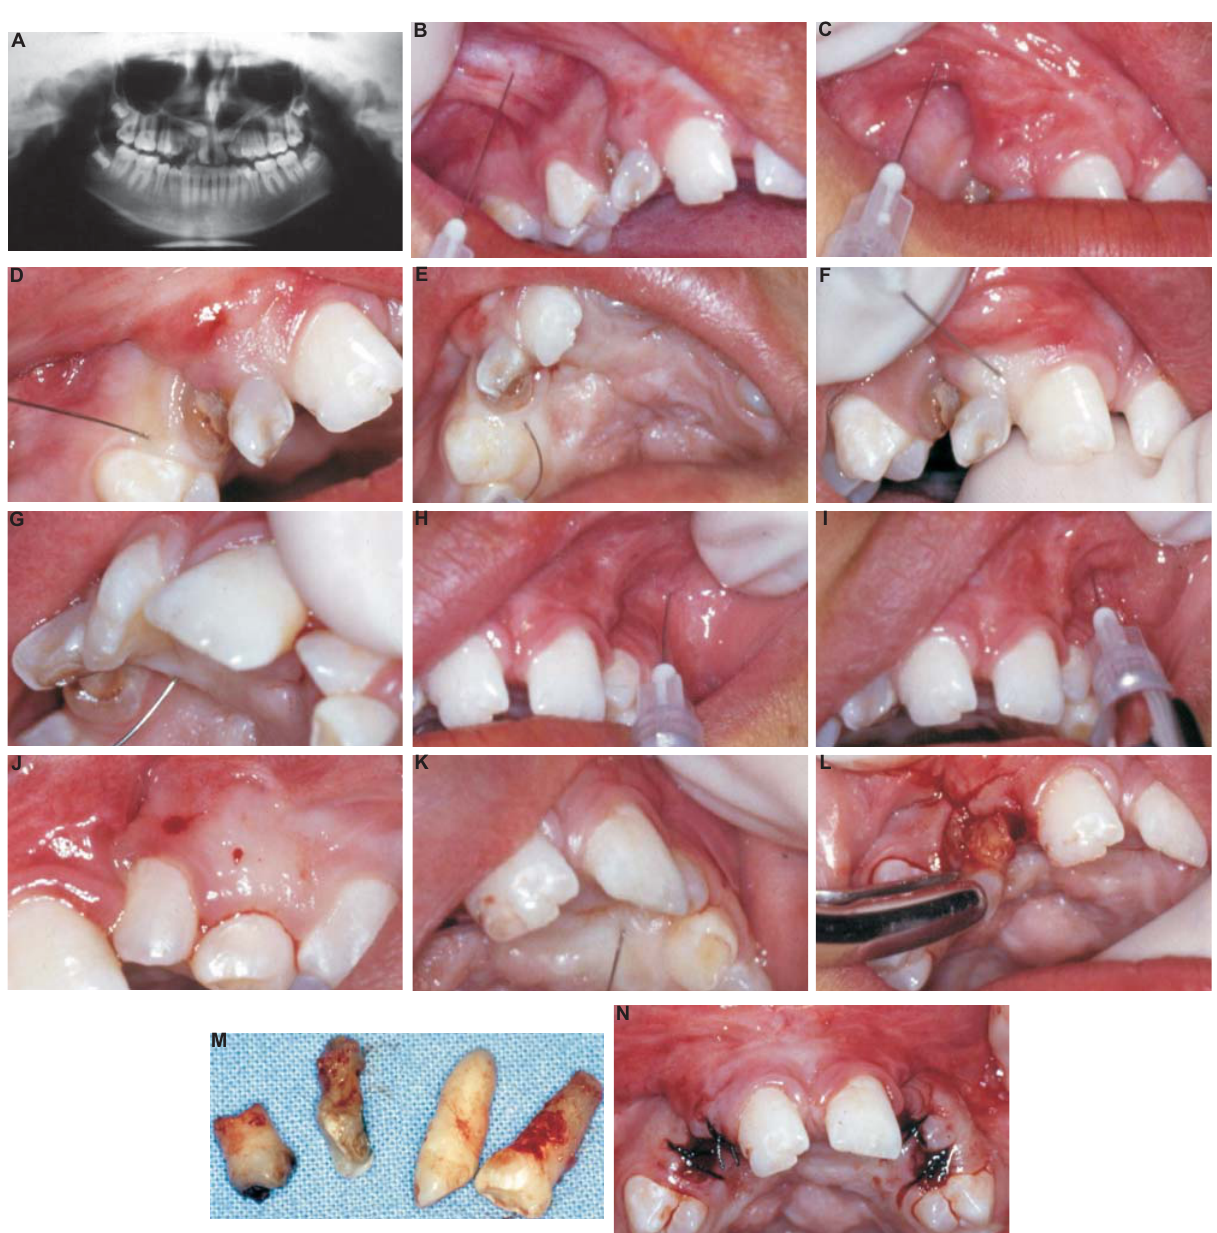
Figure 2- Patient with a complete bilateral cleft lip and palate:A: Panoramic radiograph showing residual teeth in the right (cid:30)(cid:11)(cid:17)(cid:31)(cid:2)(cid:5)(cid:8)(cid:13)(cid:14)(cid:5)(cid:9)(cid:18)(cid:15)(cid:17)(cid:12)(cid:13)(cid:18)(cid:10)(cid:17)(cid:12)(cid:8)(cid:12)"(cid:5)(cid:2)(cid:17)(cid:17)(cid:2)(cid:4)(cid:5)(cid:7)(cid:13)(cid:5)(cid:2)(cid:4)(cid:17)(cid:5)(cid:11)(cid:17)(cid:31)(cid:2)(cid:5)(cid:30)(cid:11)(cid:17)(cid:31)(cid:2)$(cid:5)(cid:6)(cid:7)(cid:2)(cid:4)(cid:5)(cid:15)(cid:3)(cid:3)(cid:12)(cid:5)(cid:16)(cid:3)(cid:13)(cid:17)(cid:5)(cid:9)(cid:18)(cid:15)(cid:15)(cid:3)(cid:12)(cid:2)(cid:19)(cid:5)(cid:20)(cid:21)(cid:5)(cid:22)(cid:13)(cid:2)(cid:12)(cid:8)(cid:3)(cid:12)(cid:8)(cid:11)(cid:5)(cid:23)(cid:7)(cid:17)(cid:6)(cid:5)(cid:8)(cid:13)(cid:14)(cid:5)(cid:26)(cid:12)(cid:9)(cid:2)(cid:5)(cid:7)(cid:13)(cid:26)(cid:11)(cid:2)(cid:12)(cid:8)(cid:2)(cid:7)(cid:3)(cid:13)(cid:5)(cid:7)(cid:13)(cid:5)(cid:2)(cid:4)(cid:17)(cid:5)(cid:15)(cid:12)(cid:17)(cid:10)(cid:3)(cid:11)(cid:8)(cid:12)(cid:5) (cid:12)(cid:17)(cid:27)(cid:7)(cid:3)(cid:13)(cid:19)(cid:5)(cid:24)(cid:21)(cid:5)(cid:29)(cid:17)(cid:30)(cid:3)(cid:13)(cid:14)(cid:5)(cid:7)(cid:13)(cid:26)(cid:11)(cid:2)(cid:12)(cid:8)(cid:2)(cid:7)(cid:3)(cid:13)(cid:5)(cid:7)(cid:13)(cid:5)(cid:2)(cid:4)(cid:17)(cid:5)(cid:30)(cid:11)(cid:17)(cid:31)(cid:2)(cid:5)(cid:8)(cid:12)(cid:17)(cid:8)(cid:19)(cid:5)(cid:28)(cid:21)(cid:5)(cid:22)(cid:13)(cid:26)(cid:11)(cid:2)(cid:12)(cid:8)(cid:2)(cid:7)(cid:3)(cid:13)(cid:5)(cid:7)(cid:13)(cid:5)(cid:2)(cid:4)(cid:17)(cid:5)(cid:16)(cid:18)(cid:30)(cid:30)(cid:8)(cid:11)(cid:5)(cid:8)(cid:9)(cid:15)(cid:17)(cid:30)(cid:2)(cid:5)(cid:3)(cid:31)(cid:5)(cid:2)(cid:4)(cid:17)(cid:5)(cid:10)(cid:8)(cid:12)(cid:27)(cid:7)(cid:13)(cid:8)(cid:11)(cid:5)(cid:27)(cid:17)(cid:13)(cid:27)(cid:7)(cid:23)(cid:8)(cid:5)(cid:8)(cid:14)%(cid:8)(cid:30)(cid:17)(cid:13)(cid:2)(cid:5)(cid:2)(cid:3)(cid:5)(cid:2)(cid:4)(cid:17)(cid:5) (cid:30)(cid:11)(cid:17)(cid:31)(cid:2)(cid:5)&(cid:15)(cid:3)(cid:9)(cid:2)(cid:17)(cid:12)(cid:7)(cid:3)(cid:12)(cid:5)(cid:10)(cid:8)’(cid:7)(cid:11)(cid:11)(cid:8)(cid:12)"(cid:5)(cid:9)(cid:17)(cid:27)(cid:10)(cid:17)(cid:13)(cid:2)(cid:5)*(cid:5)(cid:12)(cid:7)(cid:27)(cid:4)(cid:2)(cid:5)(cid:9)(cid:7)(cid:14)(cid:17)+(cid:19)(cid:5)!(cid:21)(cid:5)(cid:22)(cid:13)(cid:26)(cid:11)(cid:2)(cid:12)(cid:8)(cid:2)(cid:7)(cid:3)(cid:13)(cid:5)(cid:7)(cid:13)(cid:5)(cid:15)(cid:8)(cid:11)(cid:8)(cid:2)(cid:8)(cid:11)(cid:5)(cid:8)(cid:9)(cid:15)(cid:17)(cid:30)(cid:2)(cid:5)(cid:3)(cid:31)(cid:5)(cid:2)(cid:4)(cid:17)(cid:5)(cid:10)(cid:8)(cid:12)(cid:27)(cid:7)(cid:13)(cid:8)(cid:11)(cid:5)(cid:27)(cid:17)(cid:13)(cid:27)(cid:7)(cid:23)(cid:8)(cid:5)(cid:8)(cid:14)%(cid:8)(cid:30)(cid:17)(cid:13)(cid:2)(cid:5)(cid:2)(cid:3)(cid:5)(cid:2)(cid:4)(cid:17)(cid:5)(cid:30)(cid:11)(cid:17)(cid:31)(cid:2)(cid:5) &(cid:2)(cid:4)(cid:17)(cid:5)(cid:15)(cid:3)(cid:9)(cid:2)(cid:17)(cid:12)(cid:7)(cid:3)(cid:12)(cid:5)(cid:10)(cid:8)’(cid:7)(cid:11)(cid:11)(cid:8)(cid:12)"(cid:5)(cid:9)(cid:17)(cid:27)(cid:10)(cid:17)(cid:13)(cid:2)(cid:5)*(cid:5)(cid:12)(cid:7)(cid:27)(cid:4)(cid:2)(cid:5)(cid:9)(cid:7)(cid:14)(cid:17)+(cid:19)(cid:5)(cid:25)(cid:21)(cid:5)(cid:22)(cid:13)(cid:26)(cid:11)(cid:2)(cid:12)(cid:8)(cid:2)(cid:7)(cid:3)(cid:13)(cid:5)(cid:7)(cid:13)(cid:5)(cid:2)(cid:4)(cid:17)(cid:5)(cid:16)(cid:18)(cid:30)(cid:30)(cid:8)(cid:11)(cid:5)(cid:8)(cid:9)(cid:15)(cid:17)(cid:30)(cid:2)(cid:5)(cid:3)(cid:31)(cid:5)(cid:2)(cid:4)(cid:17)(cid:5)(cid:10)(cid:8)(cid:12)(cid:27)(cid:7)(cid:13)(cid:8)(cid:11)(cid:5)(cid:27)(cid:17)(cid:13)(cid:27)(cid:7)(cid:23)(cid:8)(cid:5)(cid:8)(cid:14)%(cid:8)(cid:30)(cid:17)(cid:13)(cid:2)(cid:5)(cid:2)(cid:3)(cid:5)(cid:2)(cid:4)(cid:17)(cid:5)(cid:30)(cid:11)(cid:17)(cid:31)(cid:2)(cid:5) &(cid:15)(cid:12)(cid:17)(cid:10)(cid:8)’(cid:7)(cid:11)(cid:11)(cid:8)(cid:12)"(cid:5)(cid:12)(cid:17)(cid:27)(cid:7)(cid:3)(cid:13)+(cid:19)(cid:5)#(cid:21)(cid:5)(cid:22)(cid:13)(cid:26)(cid:11)(cid:2)(cid:12)(cid:8)(cid:2)(cid:7)(cid:3)(cid:13)(cid:5)(cid:7)(cid:13)(cid:5)(cid:2)(cid:4)(cid:17)(cid:5)(cid:15)(cid:8)(cid:11)(cid:8)(cid:2)(cid:8)(cid:11)(cid:5)(cid:8)(cid:9)(cid:15)(cid:17)(cid:30)(cid:2)(cid:5)(cid:3)(cid:31)(cid:5)(cid:2)(cid:4)(cid:17)(cid:5)(cid:10)(cid:8)(cid:12)(cid:27)(cid:7)(cid:13)(cid:8)(cid:11)(cid:5)(cid:27)(cid:17)(cid:13)(cid:27)(cid:7)(cid:23)(cid:8)(cid:5)(cid:8)(cid:14)%(cid:8)(cid:30)(cid:17)(cid:13)(cid:2)(cid:5)(cid:2)(cid:3)(cid:5)(cid:2)(cid:4)(cid:17)(cid:5)(cid:30)(cid:11)(cid:17)(cid:31)(cid:2)(cid:5)&(cid:15)(cid:12)(cid:17)(cid:10)(cid:8)’(cid:7)(cid:11)(cid:11)(cid:8)(cid:12)"(cid:5)(cid:12)(cid:17)(cid:27)(cid:7)(cid:3)(cid:13)+(cid:19)(cid:5) /(cid:21)(cid:5)(cid:25)(cid:7)(cid:12)(cid:9)(cid:2)(cid:5)(cid:7)(cid:13)(cid:26)(cid:11)(cid:2)(cid:12)(cid:8)(cid:2)(cid:7)(cid:3)(cid:13)(cid:5)(cid:7)(cid:13)(cid:5)(cid:2)(cid:4)(cid:17)(cid:5)(cid:15)(cid:12)(cid:17)(cid:10)(cid:3)(cid:11)(cid:8)(cid:12)(cid:5)(cid:12)(cid:17)(cid:27)(cid:7)(cid:3)(cid:13)(cid:5)(cid:3)(cid:13)(cid:5)(cid:2)(cid:4)(cid:17)(cid:5)(cid:11)(cid:17)(cid:31)(cid:2)(cid:5)(cid:9)(cid:7)(cid:14)(cid:17)(cid:19)(cid:5)(cid:22)(cid:21)(cid:5)(cid:29)(cid:17)(cid:30)(cid:3)(cid:13)(cid:14)(cid:5)(cid:7)(cid:13)(cid:26)(cid:11)(cid:2)(cid:12)(cid:8)(cid:2)(cid:7)(cid:3)(cid:13)(cid:5)(cid:7)(cid:13)(cid:5)(cid:2)(cid:4)(cid:17)(cid:5)(cid:30)(cid:11)(cid:17)(cid:31)(cid:2)(cid:5)(cid:8)(cid:12)(cid:17)(cid:8)(cid:19)(cid:5)6(cid:21)(cid:5)(cid:22)(cid:13)(cid:26)(cid:11)(cid:2)(cid:12)(cid:8)(cid:2)(cid:7)(cid:3)(cid:13)(cid:5)(cid:7)(cid:13)(cid:5)(cid:2)(cid:4)(cid:17)(cid:5)(cid:16)(cid:18)(cid:30)(cid:30)(cid:8)(cid:11)(cid:5) (cid:8)(cid:9)(cid:15)(cid:17)(cid:30)(cid:2)(cid:5)(cid:3)(cid:31)(cid:5)(cid:2)(cid:4)(cid:17)(cid:5)(cid:10)(cid:8)(cid:12)(cid:27)(cid:7)(cid:13)(cid:8)(cid:11)(cid:5)(cid:27)(cid:17)(cid:13)(cid:27)(cid:7)(cid:23)(cid:8)(cid:5)(cid:8)(cid:14)%(cid:8)(cid:30)(cid:17)(cid:13)(cid:2)(cid:5)(cid:2)(cid:3)(cid:5)(cid:2)(cid:4)(cid:17)(cid:5)(cid:30)(cid:11)(cid:17)(cid:31)(cid:2)(cid:5)&(cid:15)(cid:3)(cid:9)(cid:2)(cid:17)(cid:12)(cid:7)(cid:3)(cid:12)(cid:5)(cid:10)(cid:8)’(cid:7)(cid:11)(cid:11)(cid:8)(cid:12)"(cid:5)(cid:9)(cid:17)(cid:27)(cid:10)(cid:17)(cid:13)(cid:2)(cid:5)*(cid:5)(cid:11)(cid:17)(cid:31)(cid:2)(cid:5)(cid:9)(cid:7)(cid:14)(cid:17)+(cid:19)(cid:5)<(cid:21)(cid:5)(cid:22)(cid:13)(cid:26)(cid:11)(cid:2)(cid:12)(cid:8)(cid:2)(cid:7)(cid:3)(cid:13)(cid:5)(cid:7)(cid:13)(cid:5)(cid:15)(cid:8)(cid:11)(cid:8)(cid:2)(cid:8)(cid:11)(cid:5)(cid:8)(cid:9)(cid:15)(cid:17)(cid:30)(cid:2)(cid:5) of the marginal gengiva adjacent to the cleft (the posterior maxillary segment - left side); L:extraction procedure; M: